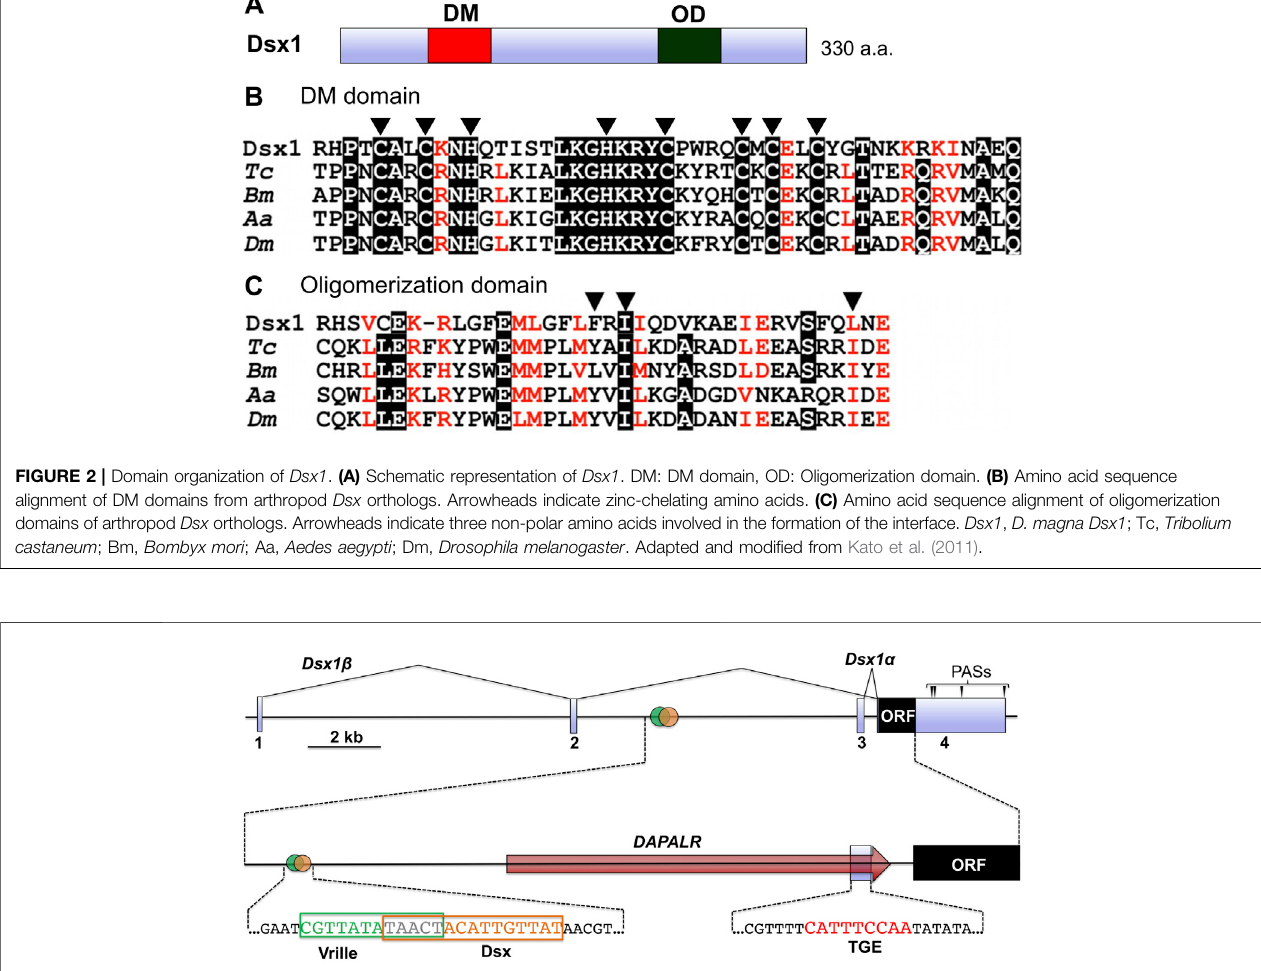
Frontiers in Cell and Developmental Biology |